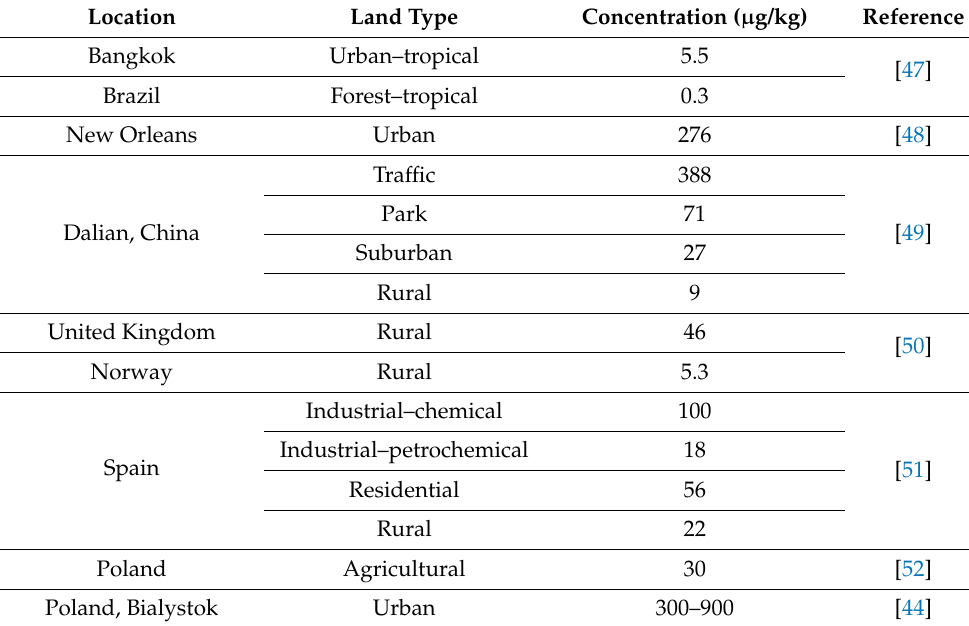
Table 3. B[ a ]P levels in soils of various countries of the world since